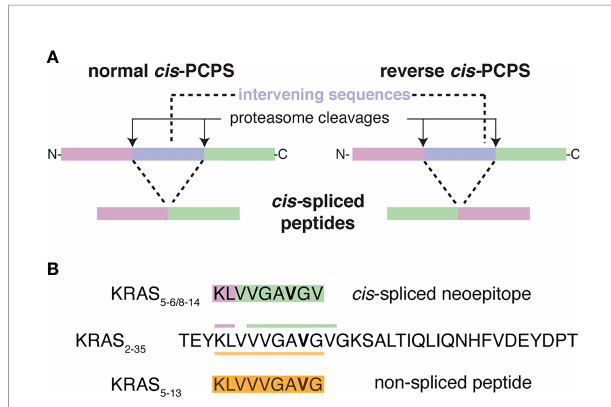
FIGURE 1 | Proteasome-catalyzed peptide splicing and the investigated KRAS G12V cis -spliced and non-spliced peptides. (A) Proteasome-generated cis -spliced peptides can be formed by cis- PCPS, when the two splice- reactants, i.e . the non-contiguous peptide fragments ligated by proteasomes, derive from the same polypeptide molecule; the ligation can occur in normal order, i.e. following the orientation from N- to C-terminus of the parental protein (normal cis -PCPS), or in the reverse order (reverse cis -PCPS). (B) The KRAS and derived from the KRAS 2-35 G12V synthetic substrate polypeptide. The G12V mutation is marked in